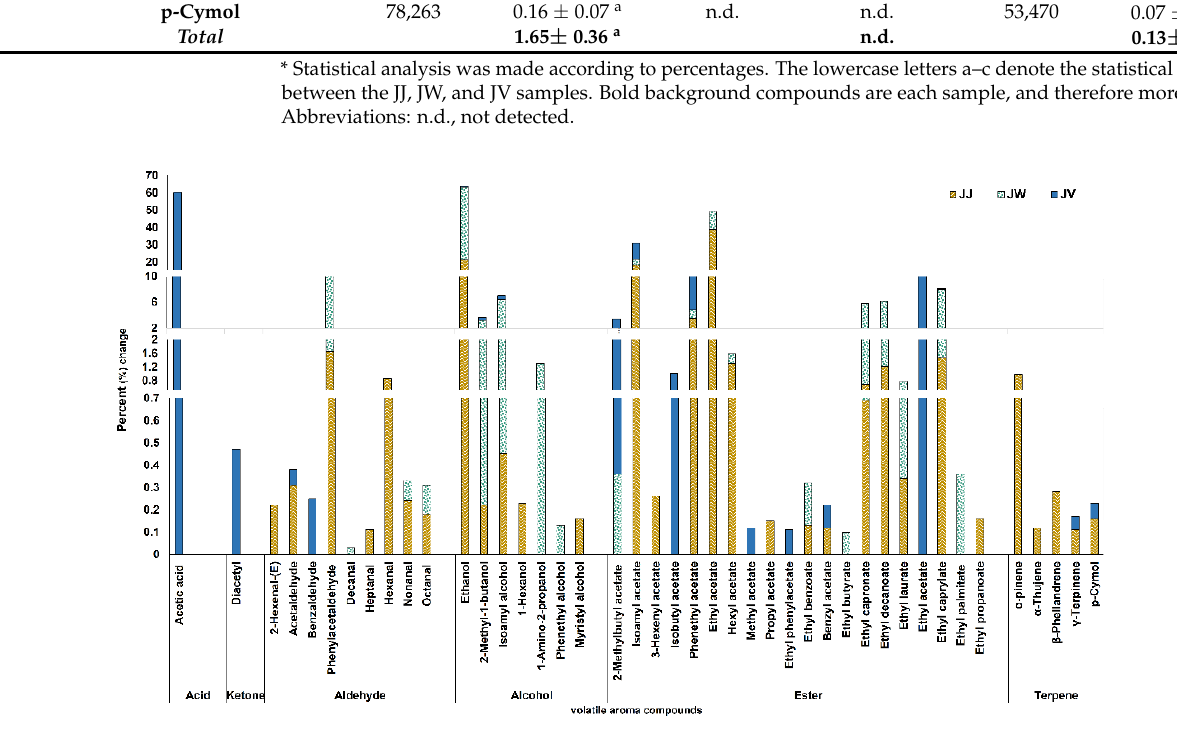
Figure 4. Volatile compounds associated with aroma of jujube juice (JJ), jujube wine (JW) and jujube vinegar (JV) (percent %). vinegar (JV) (percent